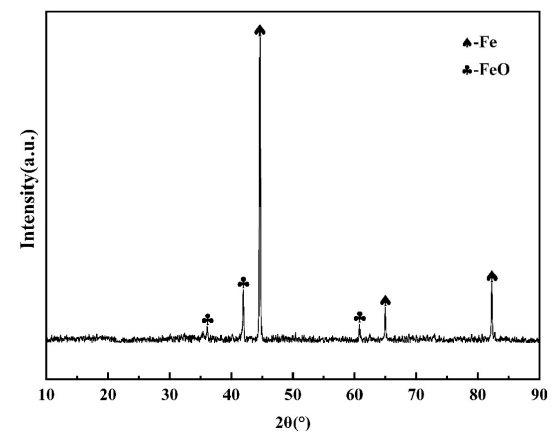
Figure 12. XRD pattern of the residual oxidized layer of coating of the unpolished steel plate.